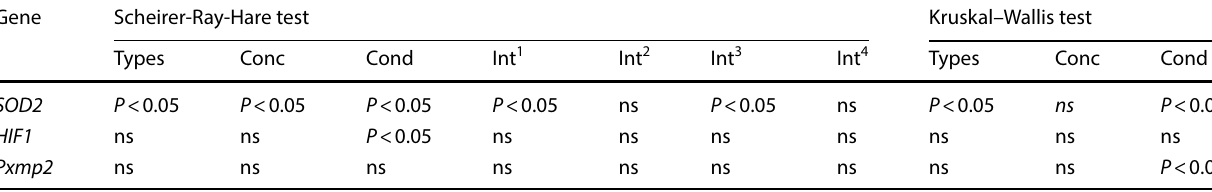
Table 2 Summary of the statistical analyses on the effect of TiO NPs, coated with different anionic (PSS) and cationic (PAH) 2 polyelectrolytes, on the mRNA expression level of SOD2 , HIF1 and